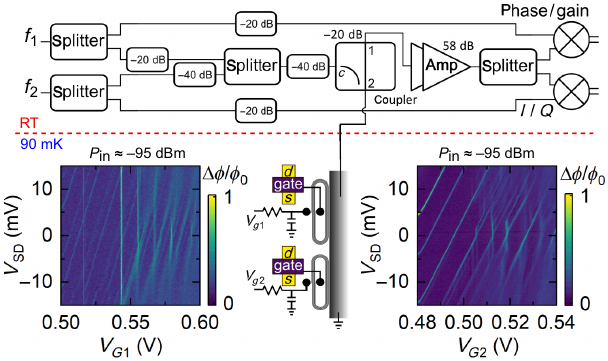
FIG. 10. Schematic of the frequency-multiplexing experiment and results. Tones from separate microwave sources ( f 1 and f 2 ) are combined and applied to two single-gate silicon NWFETs via a common microwave waveguide. The reflected signal is ampli- fied at room temperature, divided, and then demodulated with the relevant reference signal ( f 1 is demodulated into phase and gain components using an Analog Devices AD8302, whereas f 2 is demodulated into I and Q using a Polyphase AD0540B). Coulomb diamonds for both devices are measured simultane- ously at 1.78 GHz (left plot) and 2.45 GHz (right plot).